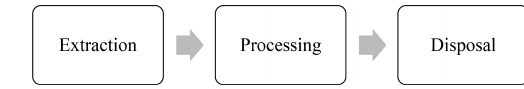
Figure 1. Linear raw material usage from left to right.